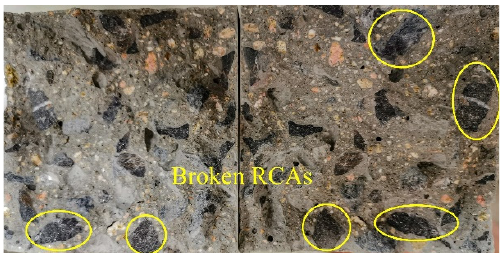
Figure 11. The typical destruction section of FRAC after splitting tensile destruction.